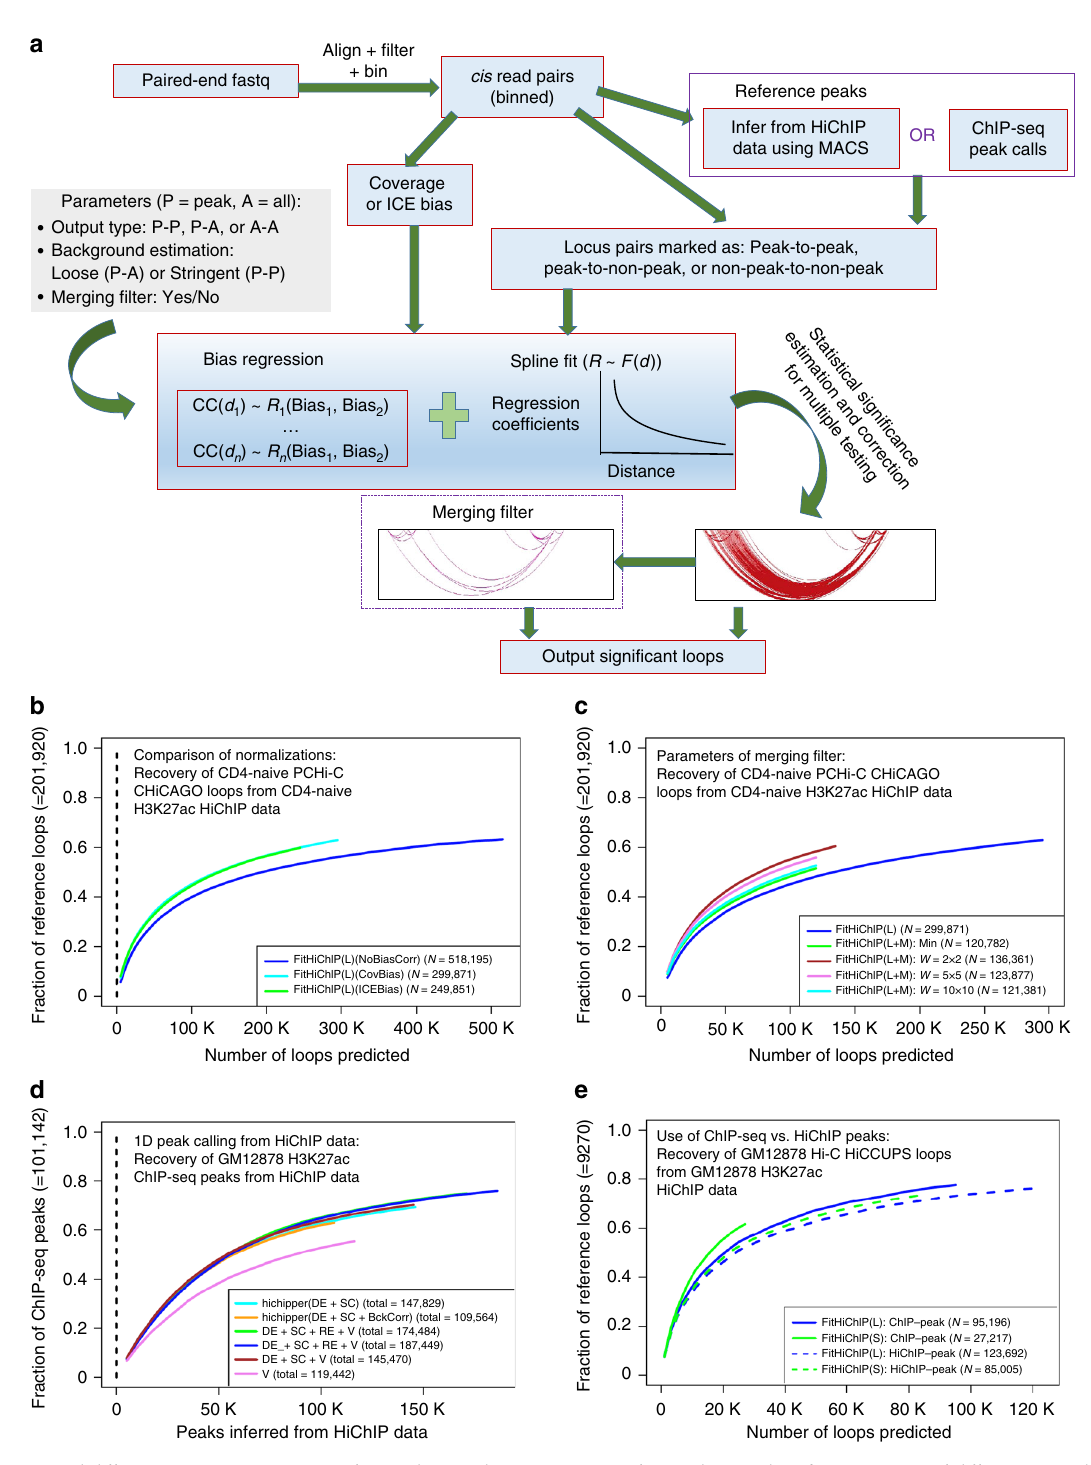
Fig. 1 Overview and different settings/parameters of FitHiChIP pipeline. a Overview of FitHiChIP pipeline. b Comparison of different normalization techniques versus no normalization for FitHiChIP in terms of recovering loops from PCHiC data on the same cell type. c Recovery performance of PCHiC loops using different settings and window sizes for our merging fi lter (M) technique. d Recovery of ChIP-seq peaks by MACS2 peaks inferred from HiChIP data using different sets of reads. e Comparison of the choice of peak calls (either from a reference ChIP-seq data or inferred from HiChIP data directly) in terms of recovering a reference set of loop calls from GM12878 Hi-C data. The symbol N indicates total number of loops (or peaks) for the corresponding method. Source data are provided as a Source Data fi